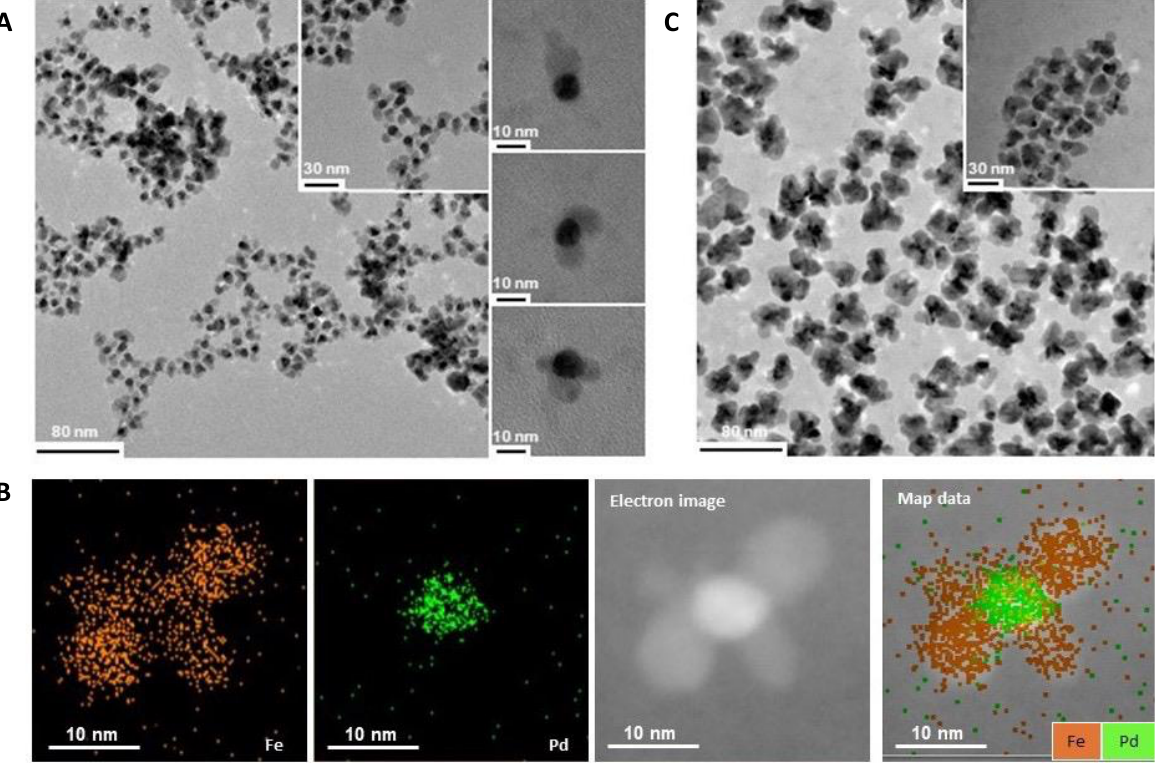
Figure 1. Characterization of Pd/Fe-oxide NPs obtained with one-pot synthesis resulting in: flower- like NPs — TEM images ( A ), incl. the three specific types of shapes they undertook (insets), and EDS ele- mental mapping with individual signals for Fe and Pd ( B ), and popcorn-like NPs — TEM images ( C ).